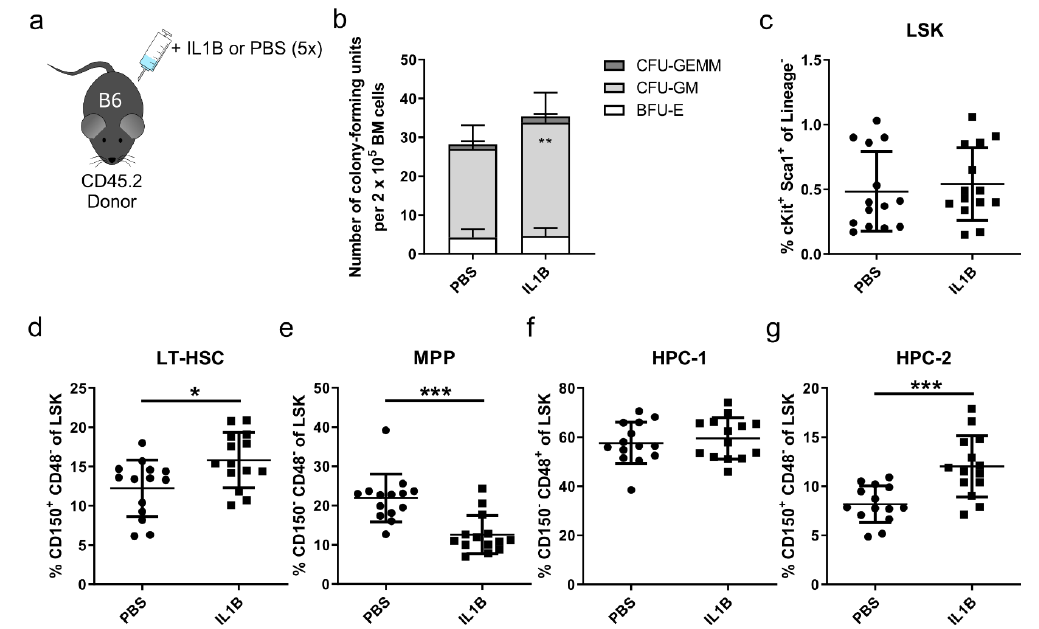
Figure 3. Challenging donor mice with IL1B leads to activation of LT-HSCs and mimics X-CGD disease pathology. ( a ) CD45.2 + donor mice were injected five times in a 2-day interval with IL1B or PBS as control. ( b ) Colony-forming assay was performed on bone marrow samples of IL1B- or PBS-treated donor mice. CFU = colony-forming unit, GEMM = granulocytic, erythroid, monocyte-macrophage, and megakaryocyte, GM = granulocyte/monocyte-macrophage, BFU = burst-forming unit, E = erythroid. Statistics: n = 4, mean ± SD, two-way ANOVA comparing row column means only, ** p < 0.01. ( c – g ) The frequency of ( c ) Sca1 + c-Kit + Lineage - cells (LSK), ( d ) CD150 + CD48 - long-term (LT-) HSCs, ( e ) CD150 - CD48 - multipotent progenitors (MPP), ( f ) CD150 - CD48 + hematopoietic progenitors type 1 (HPC-1), and ( g ) CD150 + CD48 + hematopoietic progenitors type 2 (HPC-2) was measured in the bone marrow of IL1B- and PBS-challenged mice. Statistics: n = 14, mean ± SD, four independent experiments, t -test, * p < 0.05, ** p < 0.01, *** p <